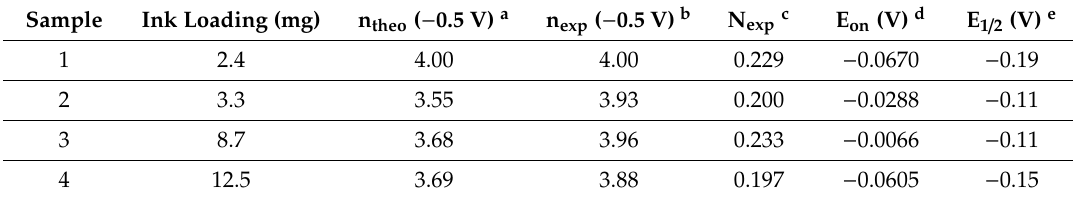
Table 2. Catalytic performances of our